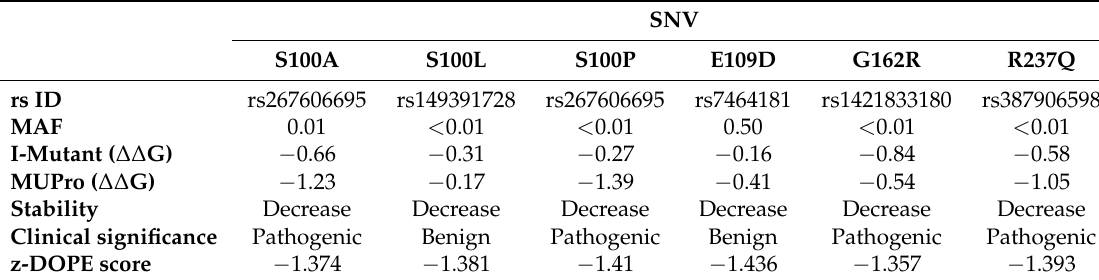
Table 1. The rs IDs, associated residue-variant substitutions and predicted variant consequences of the identified α -carbonic anhydrase VIII single nucleotide variants (SNVs). Clinical significance data obtained from Clinvar. VAPOR was used to conduct I-Mutant and MUpro